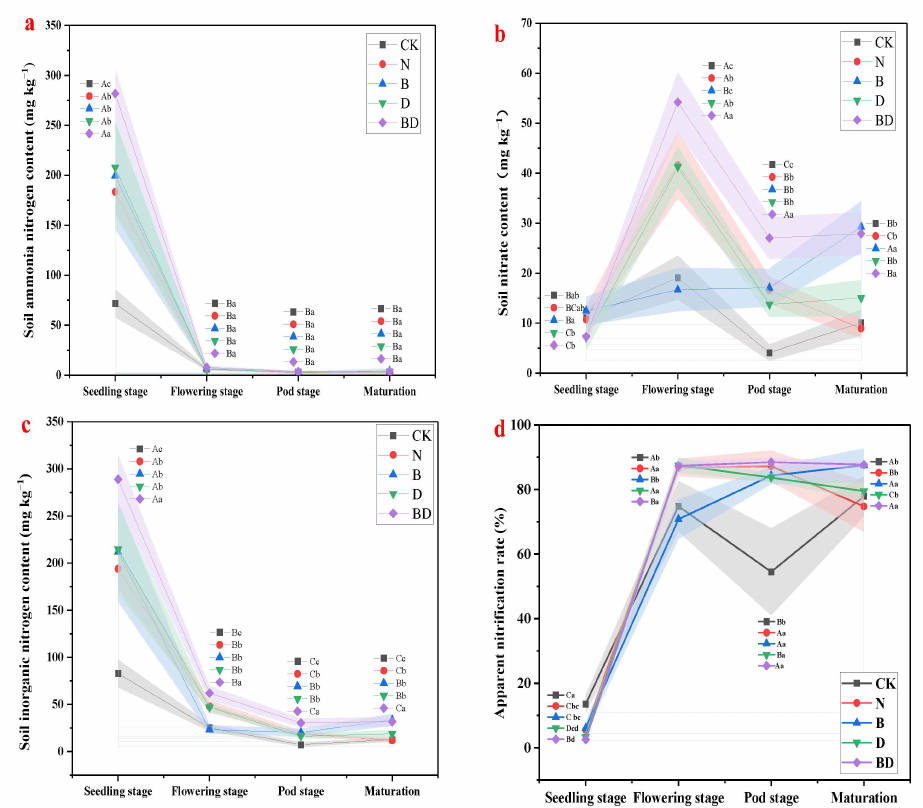
Figure 2. Effects of biochar and inhibitor addition on the soil’s ammonium nitrogen, nitrate nitrogen inorganic nitrogen, and apparent nitrification rate. ( a ) Soil ammonia content; ( b ) Soil nitrate content; ( c ) Soil inorganic nitrogen content; ( d ) Apparent nitrification rate. Small letters in the figure represent the significant difference among treatments in the same period ( n = 5, p < 0.05), while uppercase letters represent the significant difference among treatments in different growth periods ( n = 5, p < 0.05), the labels in the figure are arranged according to the significant difference at the same time. The same below.